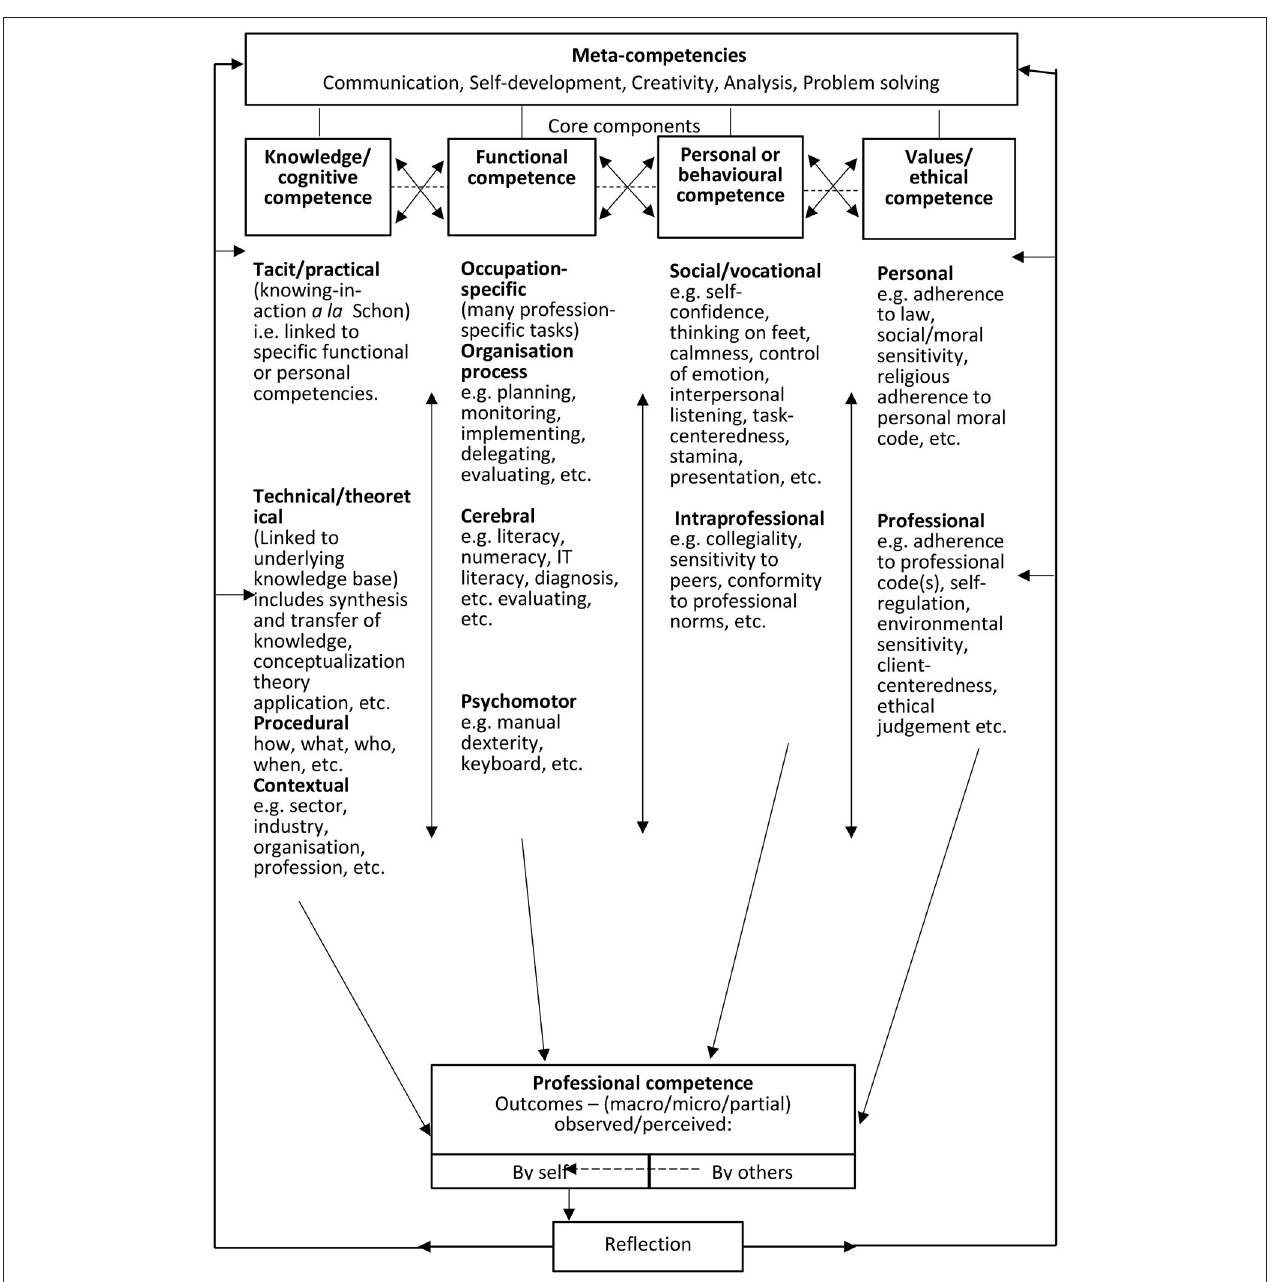
FIGURE 2 | The categorisation of meta-competencies. Source : Adapted from Cheetham and Chivers (1996:27).